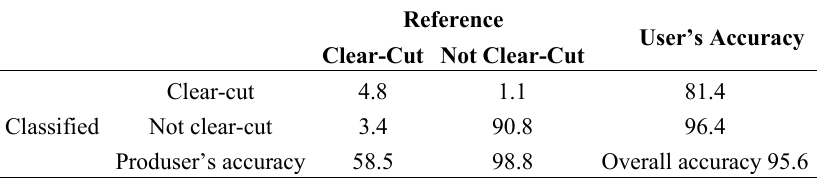
Table 3. Results with C-band SRTM at the stand level: Confusion matrix (%) of stand classification against the logging records. The classification threshold was − 9 m DSM change ( N = 3,181 stands).